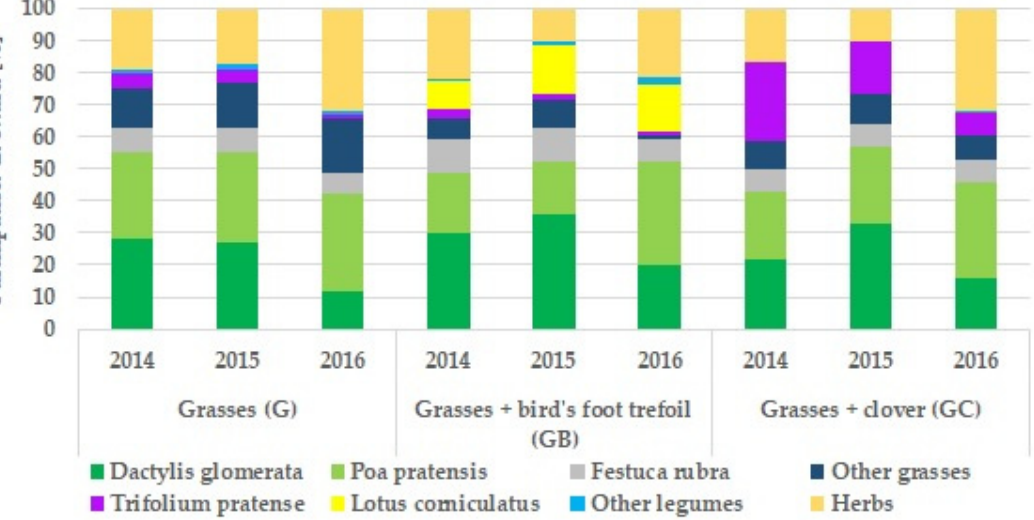
Figure 1. The percentage of the dominant plant species in the three types of meadow sward (G, GB, GC) in study years (2014–2016).